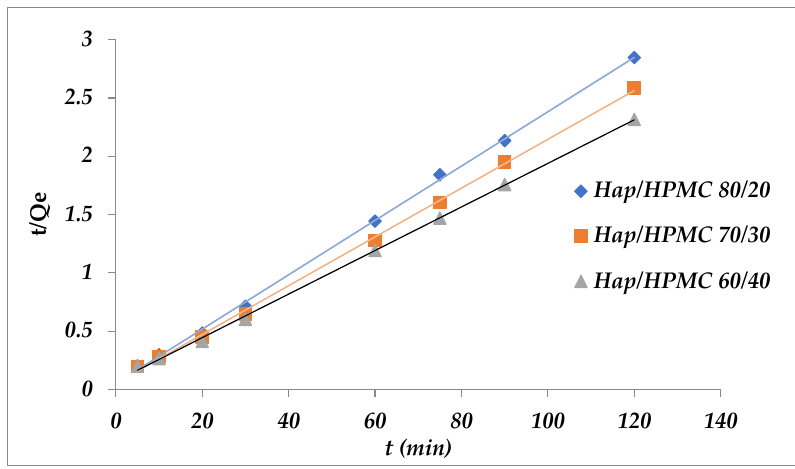
Figure 18. Pseudo-second-order kinetic model applied to the adsorption of MB by the composites. Table 6. Kinetic parameters of MB adsorption on composites.